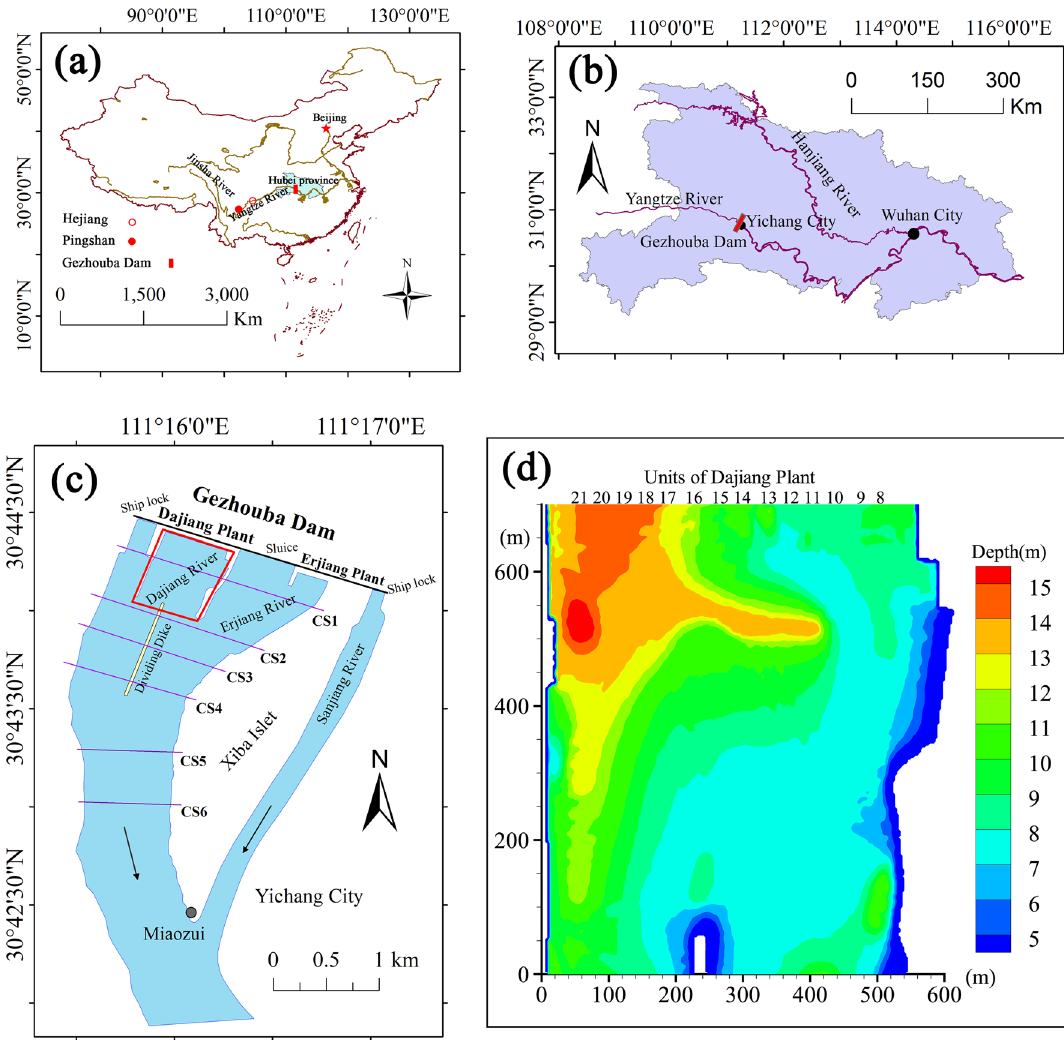
Figure 9. Location of the study area. ( a ) Location of Yangtze River and Hubei Province in China; ( b ) Location of Gezhouba Dam in Hubei Province, which is shown in red; ( c ) General condition of the field survey and location of the cross-sections (CS1–CS6); ( d ) Location of the units of Dajiang Plant and bathymetric map of the study area. Maps in figure ( a ), ( b ) and ( c ) generated in ArcGIS Pro (https:// www. esri. com/ en- us/ arcgis/ produ cts/ arcgis- pro/ overv iew). Map in figure ( d ) generated in Tecplot360 EX 2020 R1 (https:// www. tecpl ot. com/ produ cts/ tecpl ot-